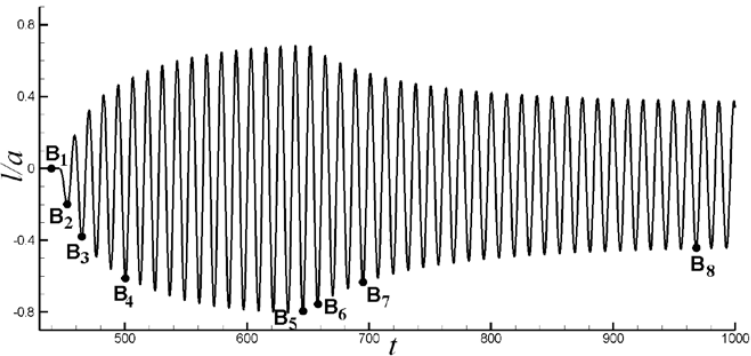
Figure 12. Evolution of the cylinder displacement with the symmetric Lorentz force ( N = 0.8) for K = 0.2.